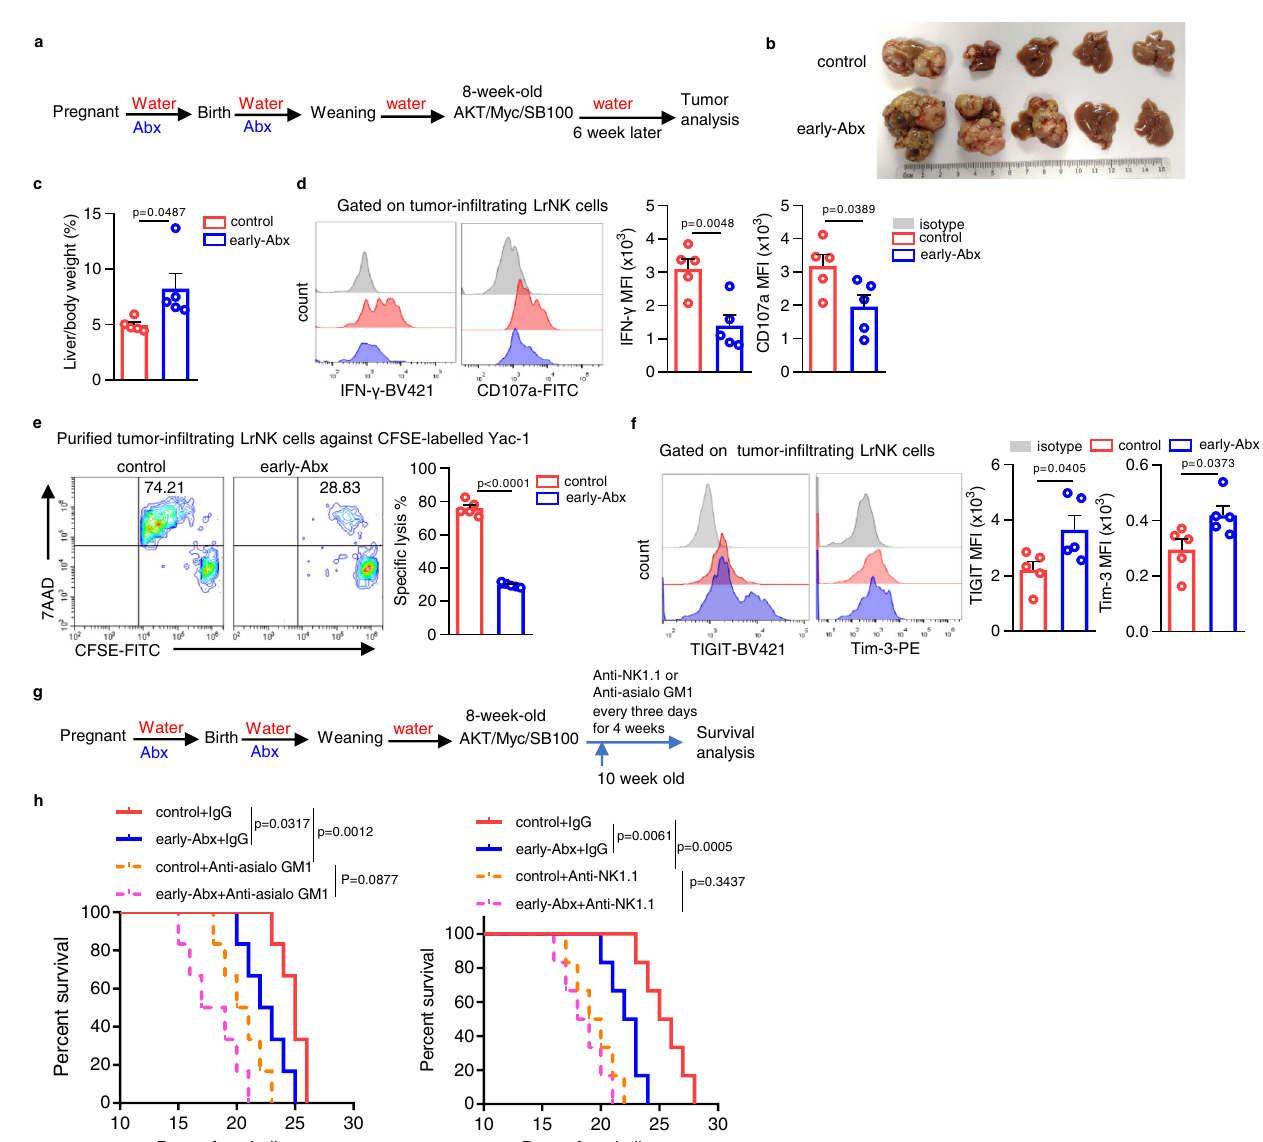
Fig. 2 | Impaired LrNK function contributes to early-Abx enhanced HCC pro- gression. a Experimental design of c-myc/AKT/SB100-induced HCC model in control or early-Abx mice. b , c In vitro tumor imaging and liver /body weight was shown ( n =5 per group). d Representative FACS plots and bar graph for the expression(MFI)ofIFN- γ andCD107ainLrNKcellsfromcontrolandearly-AbxHCC mice ( n =5 per group). e Representative FACS plots and bar graph for the cyto- toxicity of LrNK cells from control or early-Abx HCC mice against CFSE-labeled YAC-1 cells ( n =5 per group). f Representative FACS plots and bar graph for the